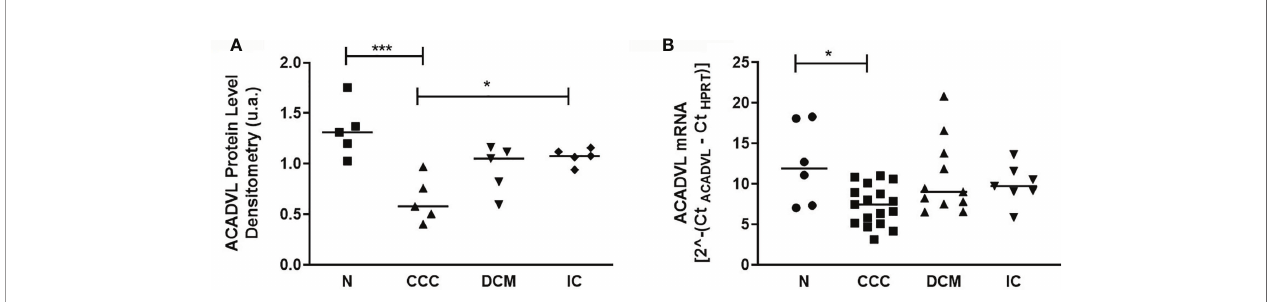
FIGURE 4 | Protein and mRNA levels of ACADVL (Very long-chain speci fi c acyl-CoA dehydrogenase) in myocardial tissue of CCC, DCM, IC and controls. (A) Densitometry measurement of ACADVL protein levels using immunoblot (One-Way ANOVA p = 0.0011). (B) . ACADVL mRNA levels assessed using real time RT- qPCR (One-Way ANOVA p = 0.0154). The horizontal lines show statistically signi fi cant changes between groups by the Tukey-Kramer test: *p < 0.05; ***p